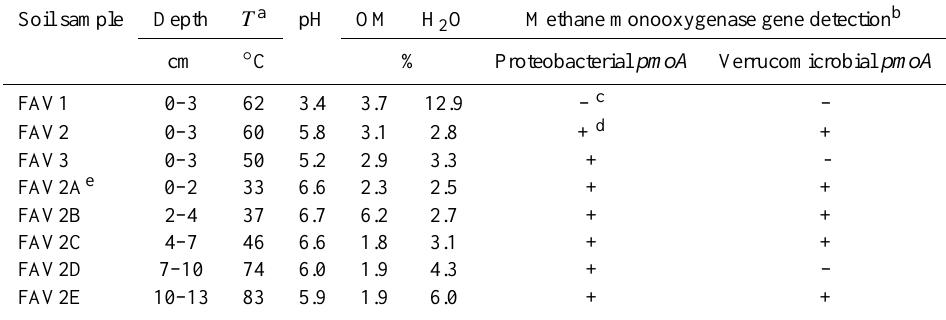
a : Table S1 shows temperatures measured up to 50cm in depth. b : Gene detection was performed by PCR with primers A189F/A62R (Holmes et al., 1995), 298f/599r and 156f/743r (this study, see text). c : Absence of an amplicon of the expected size.